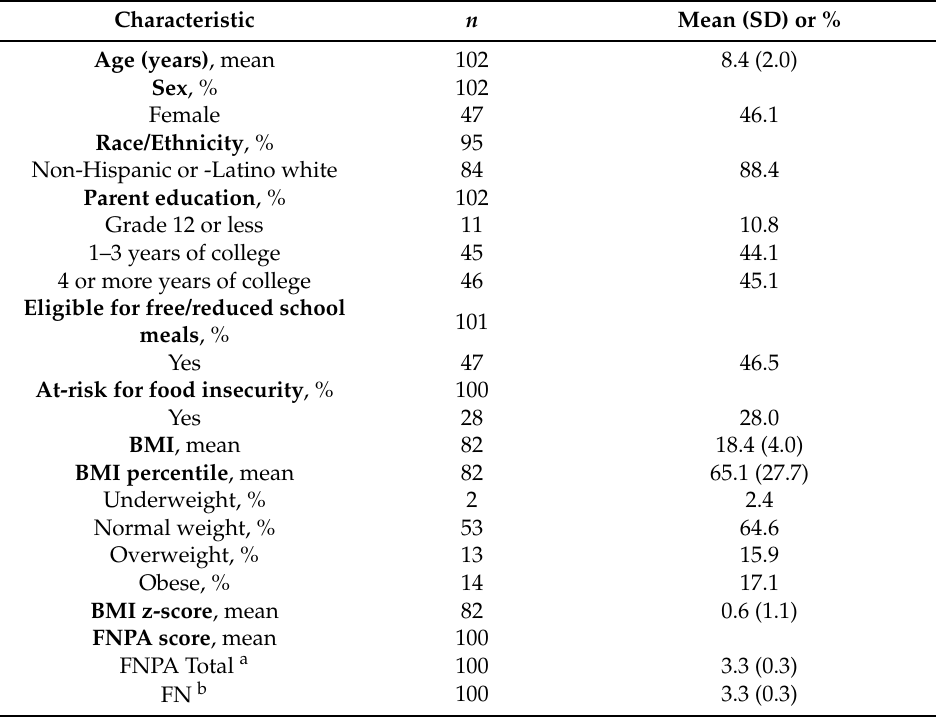
Table 2. Characteristics of rural elementary school-age children.